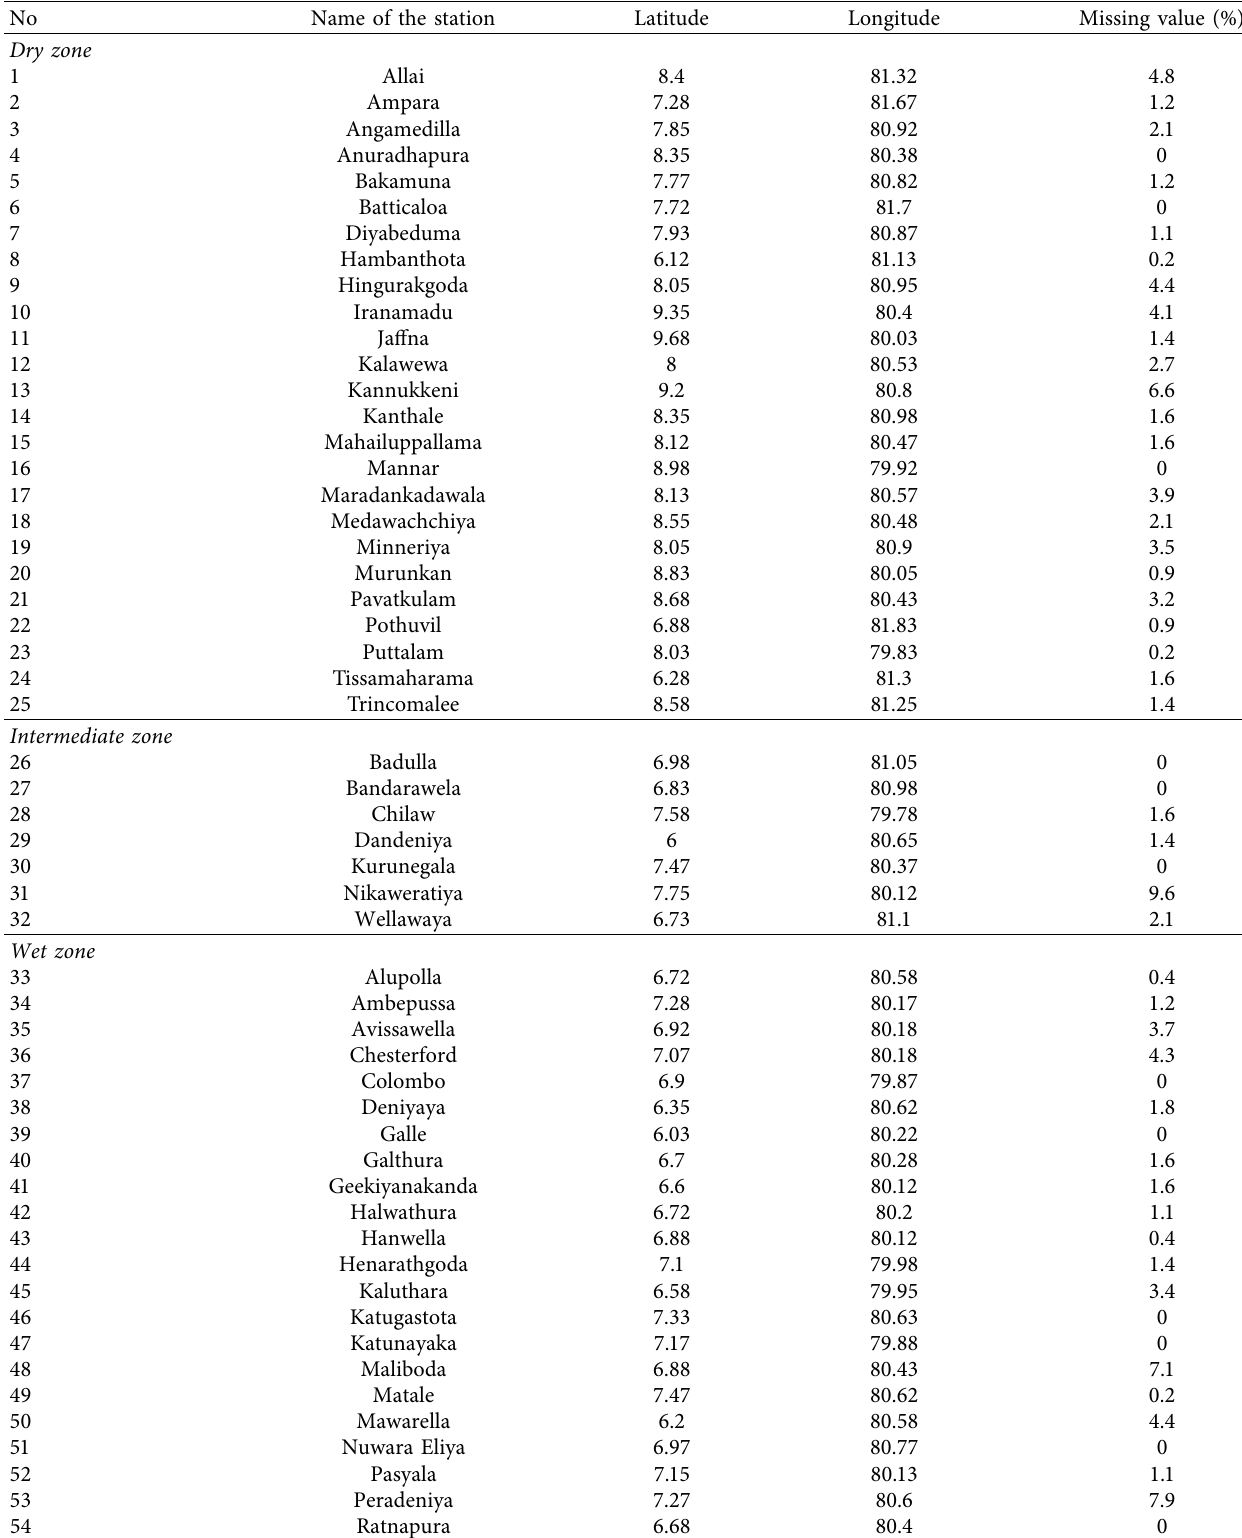
Table 1: Geographical coordinates of meteorological stations used for the